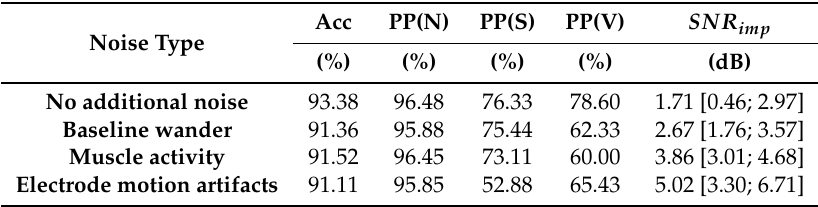
Table 5. Values of Acc, PP(N), PP(S), PP(V), and SNR imp for selected 5-minute ECG segments corrupted by various types of noise.